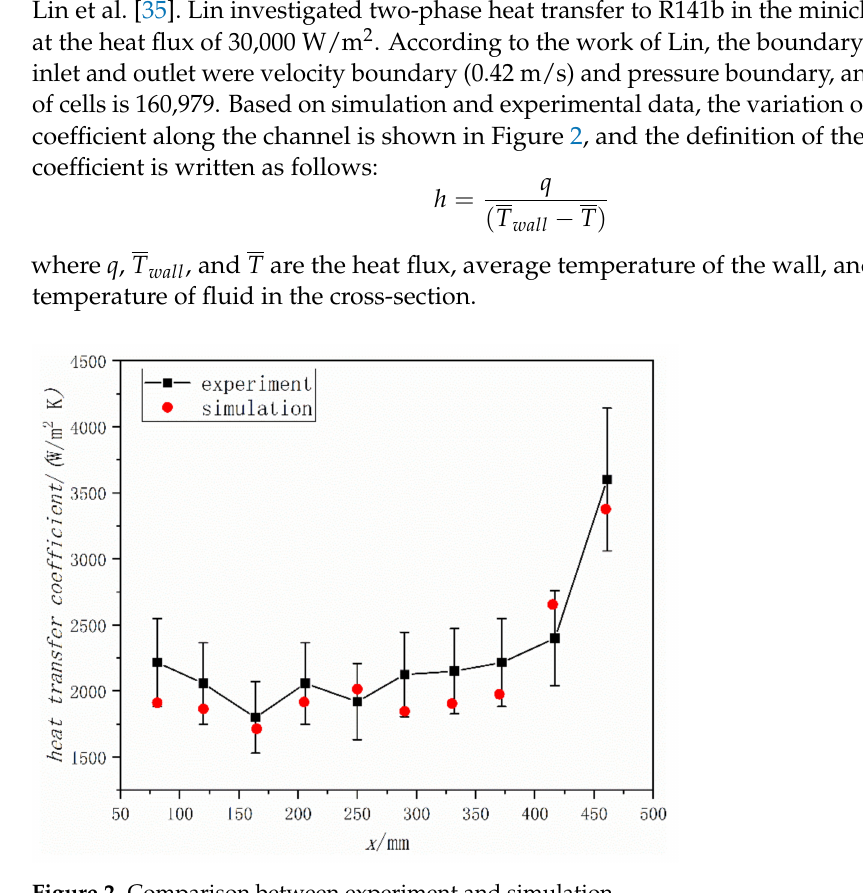
Figure 2. Comparison between experiment and